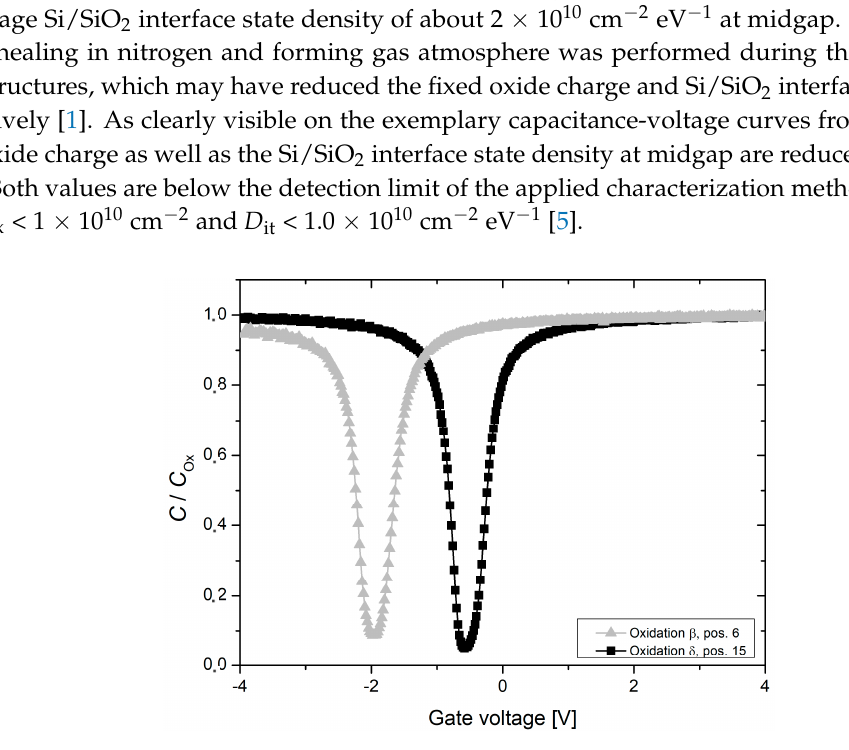
Figure 5. Exemplary results of quasi static capacitance-voltage measurements, which were performed on one test wafer from the oxidation runs β and δ , respectively. Measurements were carried out at metal oxide semi-conductor (MOS) capacitors (area 1 mm 2 ) in the center of each wafer.